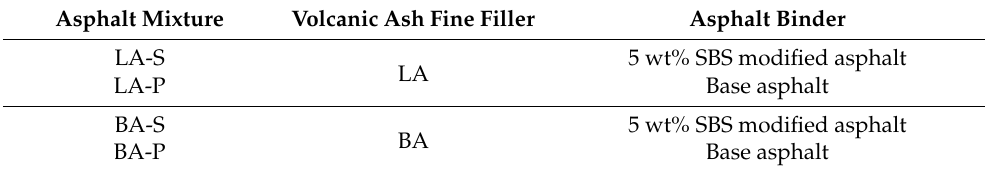
Table 3. The composition of mixtures with different fine fillers and asphalt binders.